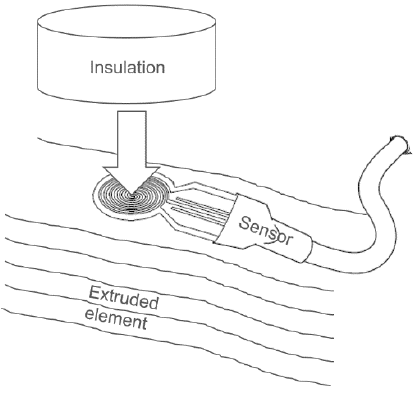
Figure 4. Test setup for the one-sided thermal conductivity measurements.